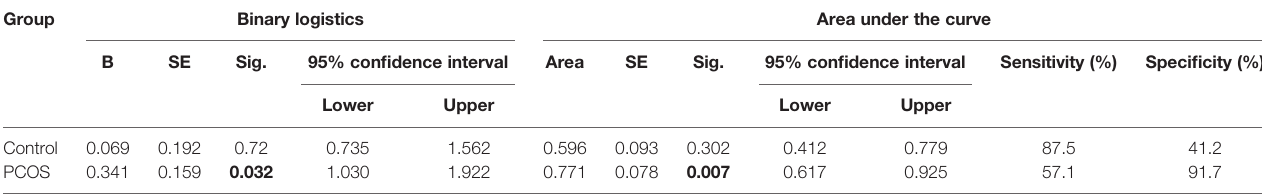
TABLE 3 | Predictive value of MALAT1 on positive clinical pregnancy. Group Binary